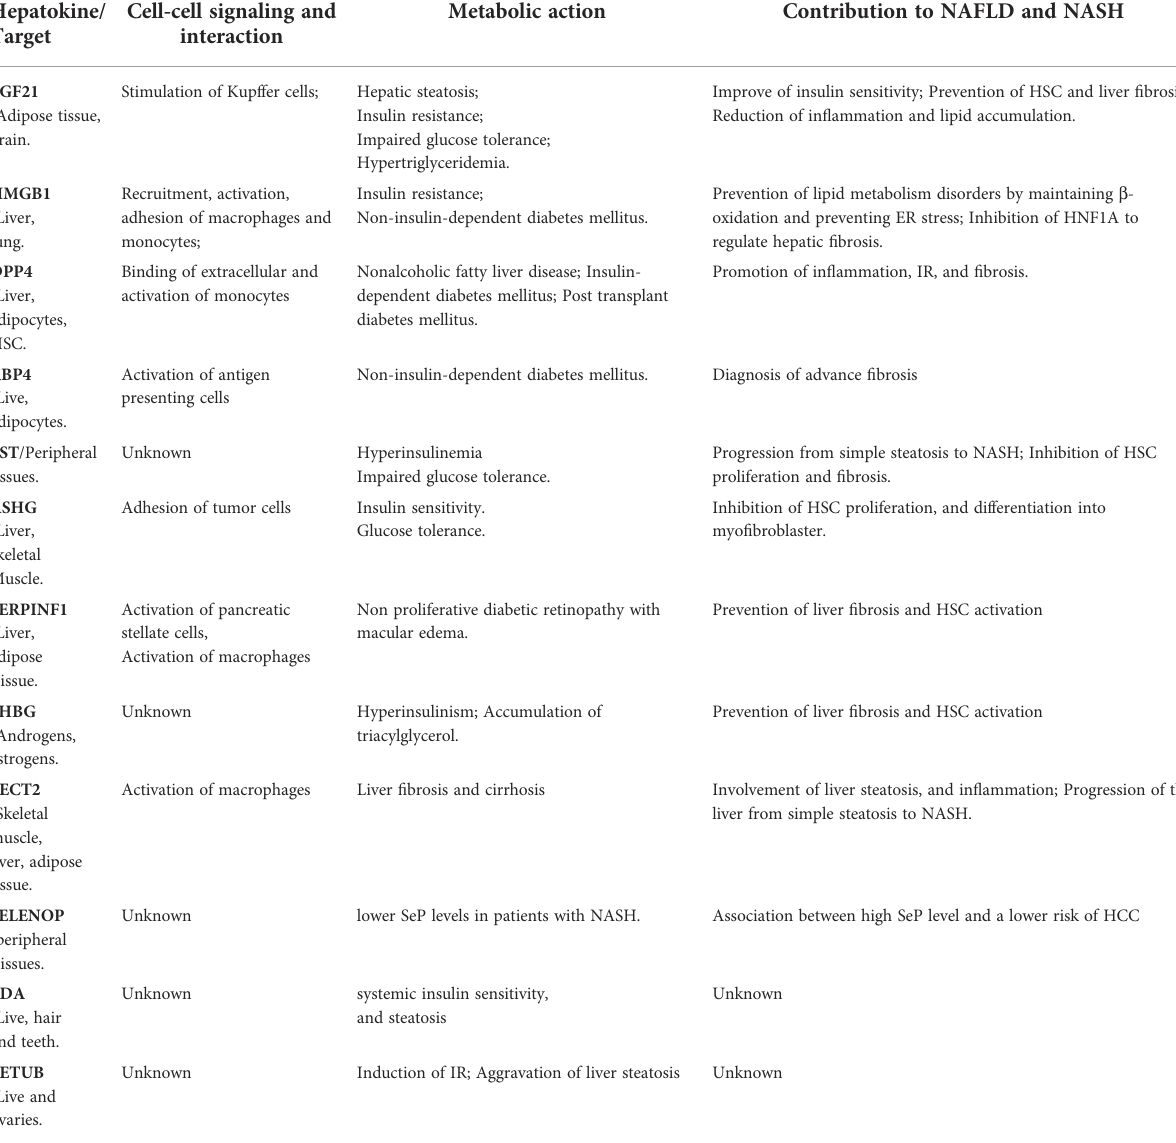
TABLE 1 IPA analysis of hepatokines related to NAFLD and NASH. Hepatokine/ Cell-cell signaling and Metabolic action Contribution to NAFLD and NASH Target interaction